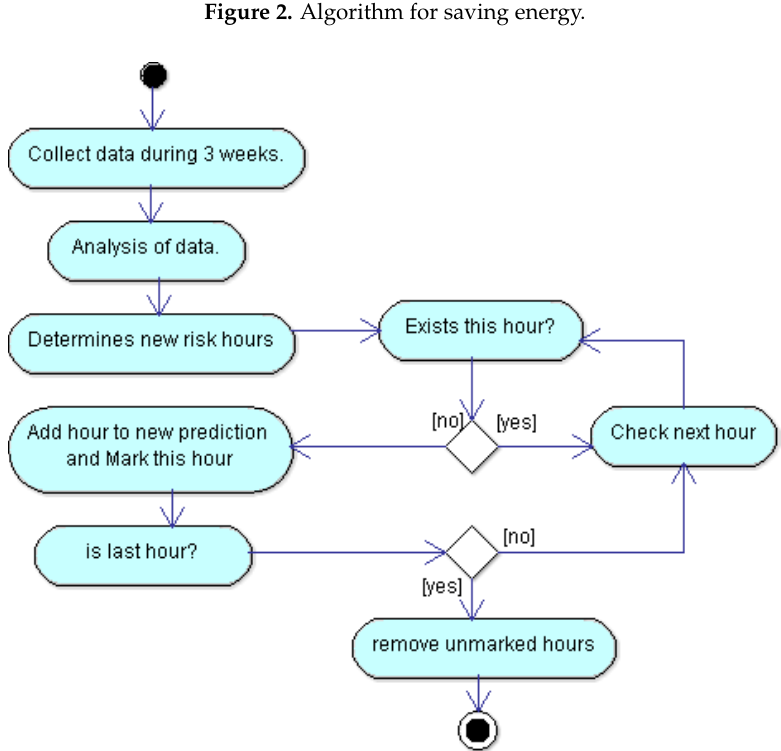
Figure 2. Algorithm for saving energy.